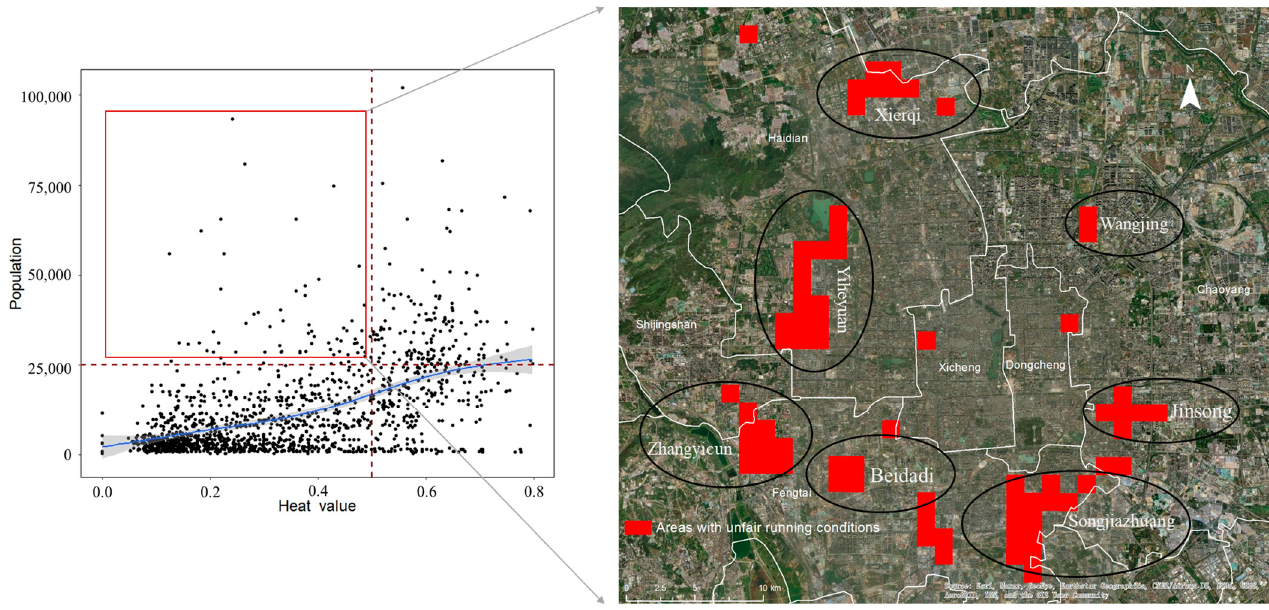
Figure 9. Areas with unfair running conditions. The source of the basemap: Esri, World Imagery, https://www.arcgis.com/home/item.html?id=10df2279f9684e4a9f6a7f08febac2a9, Accessed on 1 April 2021.